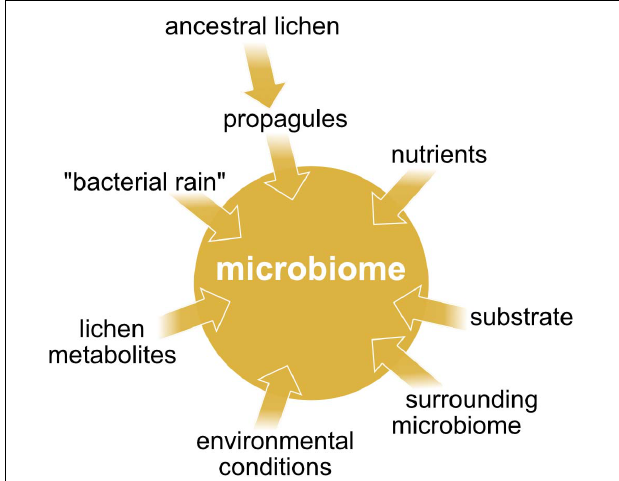
FIGURE 6 | The main factors affecting the microbiome composition in